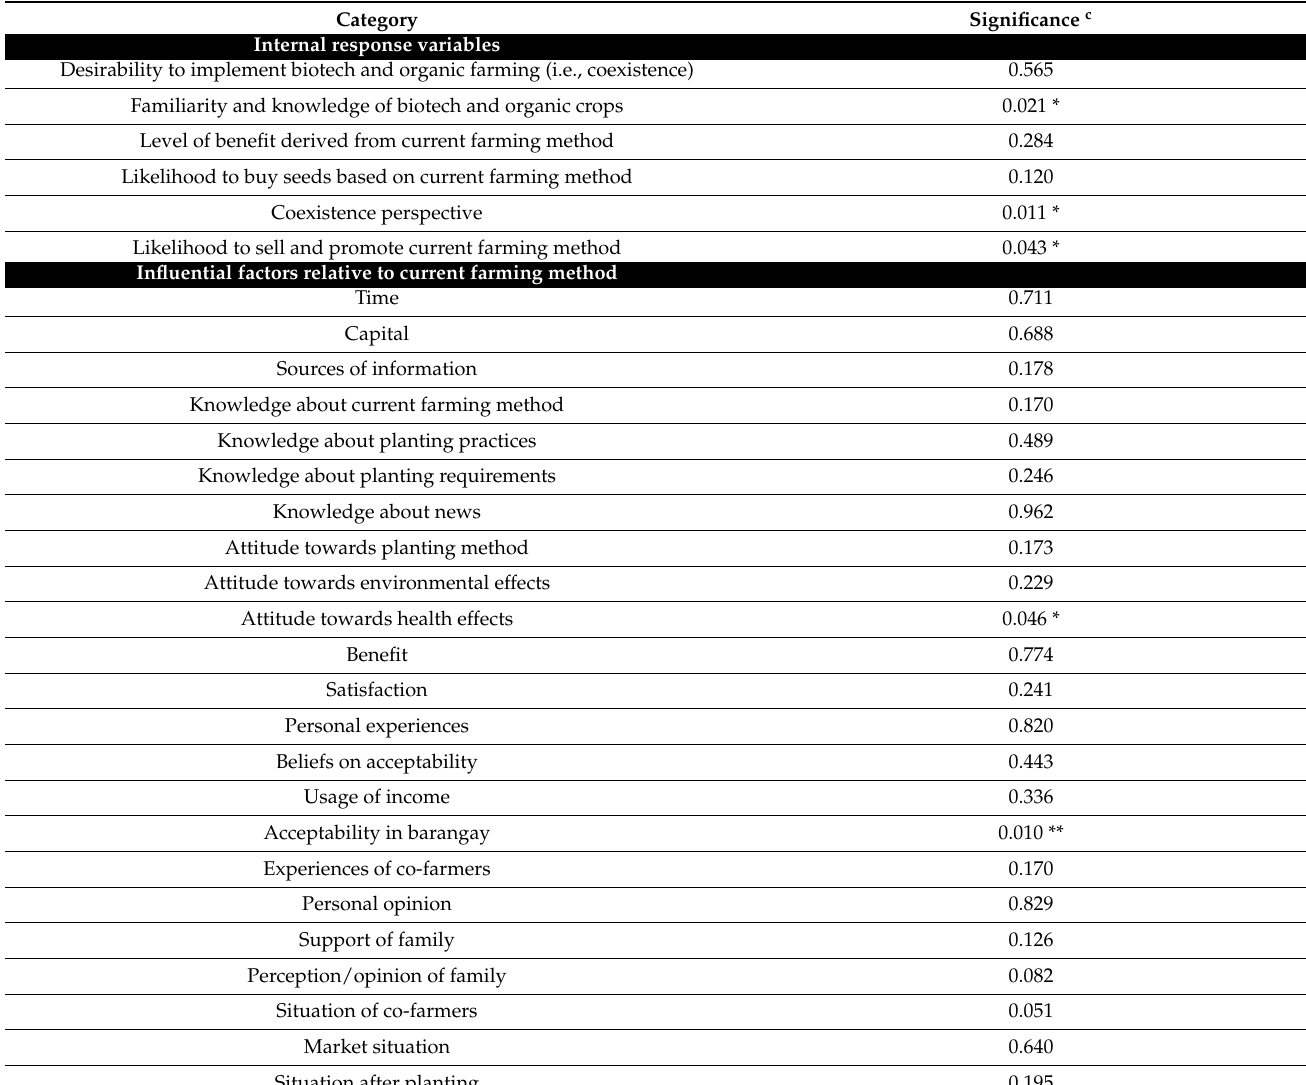
Table 4. Between-group comparison a of biotech farmers and organic farmers in terms of internal response variables b and influential factors relative to current farming method. Category Significance c Internal response